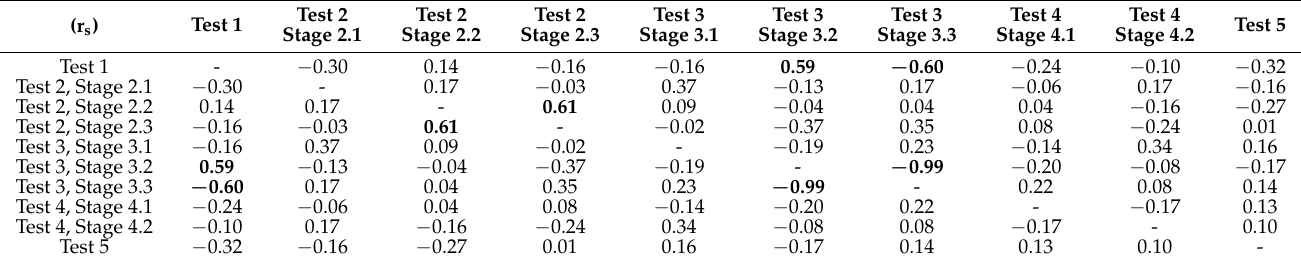
Figure 4. Distribution of Test 5 results for the groups—Social isolation test: points for the will to walk away from the other horses (a square shows the mean, a box corresponds to the range of the mean ± standard error, and “whiskers” show the range of the mean ± standard deviation). A significant difference between the groups is confirmed by the value of p < 0.05. Table 5. Spearman rank correlation coefficients (r s ) for the results of subsequent tests and their stages (the values statistically significant at 0.05 are in